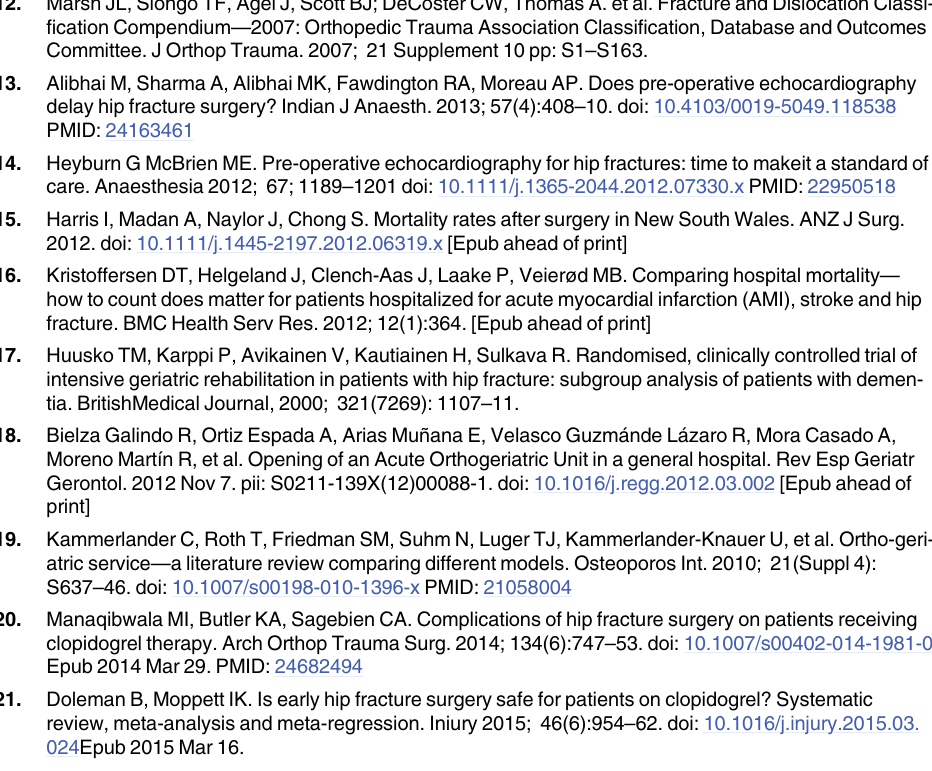
PLOS ONE | DOI:10.1371/journal.pone.0158607 July 7,